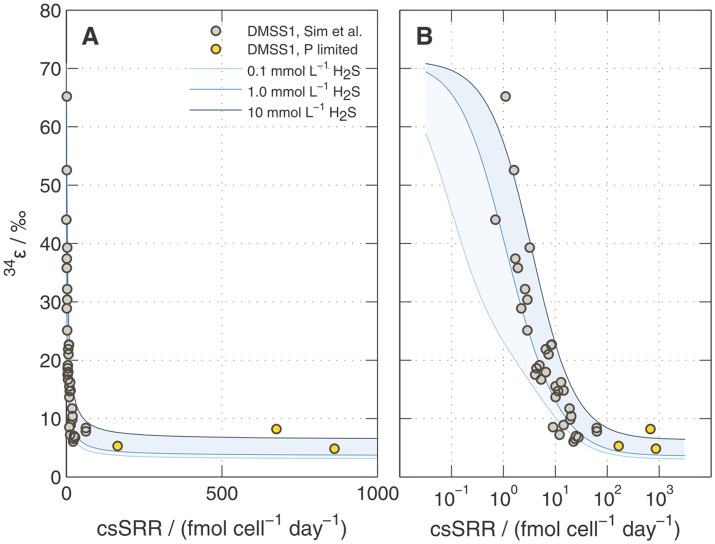
Predicted 34ε during sulfate reduction by DMSS-1 following Wing and Halevy (2014). Calculations are shown for three different H2S concentrations (0.1, 1, and 10 mM) keeping [SO42-]out constant at 20 mM. Overlaid on the model results are the data shown in Figure 6. Panels (A) and (B) show the same information but with linear and logarithmic x-axis scales (respectively).